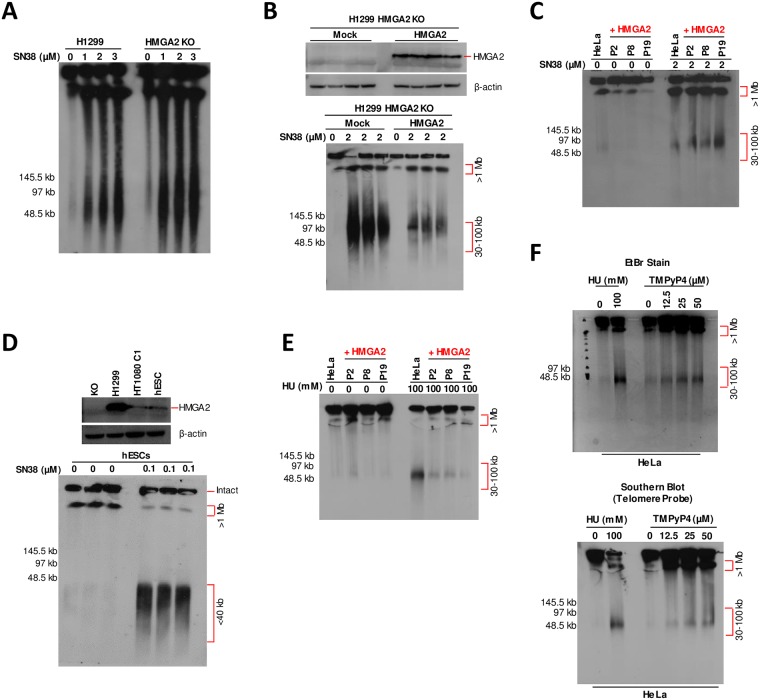
Expression of HMGA2 affects human subtelomeric domains upon induced replication stress.(A) Southern blot analysis of H1299 cells (parental and HMGA2 KO cell line) after PFGE separation using telomere-specific probes. SN38 treatment at three different doses as indicated was done for 48 h, with DMSO used as control. (B) Western blot showing exogenous expression of HMGA2 (top panel) after transfection with 1.5 μg HMGA2 expression vector in H1299 HMGA2 KO cells (mock vector served as control). Southern blot analysis of HMGA2 KO transfected cells after PFGE separation using telomere-specific probes (bottom panel). 2 μM SN38 treatment was done for 48 h, with DMSO used as control (n = 3 independent transfection experiments followed by SN38 treatment). (C) Representative Southern blot analysis of HeLa cells (parental and three recombinant HMGA2-expressing cell lines) after PFGE separation using telomere-specific probe. 2 μM SN38 treatment was for 48 h, with DMSO as control (n = 3 independent experiments). (D) Western blot showing HMGA2 expression for indicated cell lines with β-actin used as internal control (top panel). Southern blot analysis of human embryonic stem (hES) cells after PFGE separation using telomere-specific probes (bottom panel). 0.1 μM SN38 treatment was for 24 h, with DMSO as control (n = 3 independent experiments). (E) Representative Southern blot analysis of HeLa cells (parental and three recombinant HMGA2-expressing cell lines) after PFGE separation using telomere-specific probe. 100 mM HU treatment was done for 24 h (n = 3 independent experiments). (F) PFGE analysis of DSB formation in HeLa cells (DNA stained with EtBr) in response to 24 h incubation with indicated doses of TMPyP4 (top panel) and the corresponding Southern blot analysis using telomere-specific probes (bottom panel). 100 mM HU treatment for 24 h was used as control for comparing telomeric DNA fragments (>1 Mb and 30–100 kb fractions).